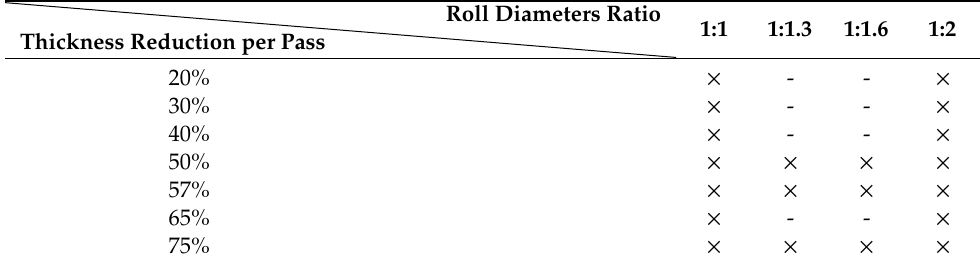
Table 1. Rolling schedule for di ff erent roll diameter